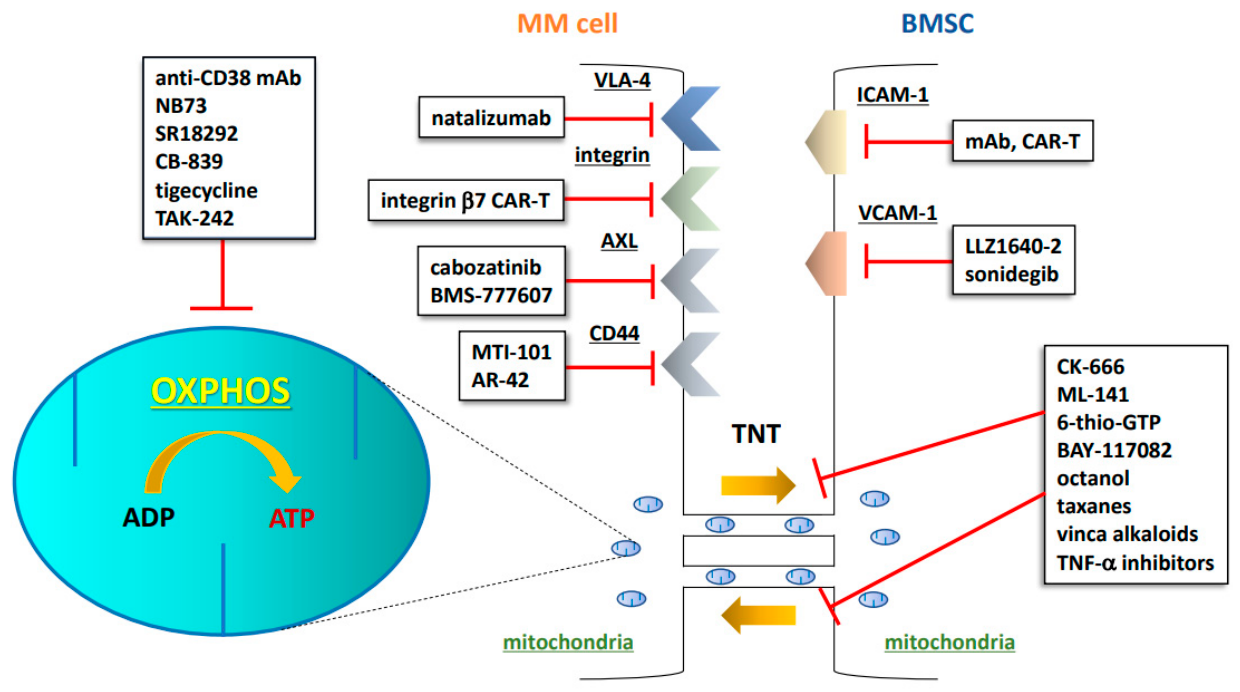
Figure 1. Schematic illustration of CAM-DR, OXPHOS, and TNTs as druggable targets in the MM niche. MM: multiple myeloma; BMSC: bone marrow stromal cell; mAb: monoclonal antibody; CAR-T: chimeric antigen receptor T cell; TNT: tunneling nanotube; OXPHOS: oxidative phosphorylation; ADP: adenosine diphosphate; ATP: adenosine triphosphate; VLA-4: very late antigen-4; AXL: AXL receptor tyrosine kinase; ICAM-1: intercellular adhesion molecule-1; VCAM-1: vascular cell adhesion molecule-1; TNF- α : tumor necrosis factor- α . Table 1. Summary of drugs/treatments targeting CAM-DR, OXPHOS, and TNTs. Druggable Drugs/treat- Description targets ments body that binds integrin-a4.